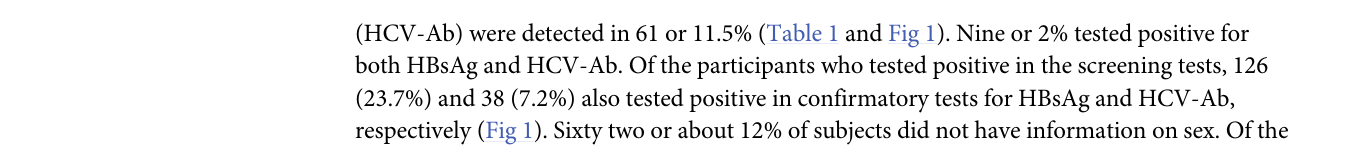
Fig 1. Viral testing algorithm. 1 HBsAg: confirmatory test for HBsAg. Confirmatory test for HCV-Ab was the same test as for the screening for HCV-Ab.